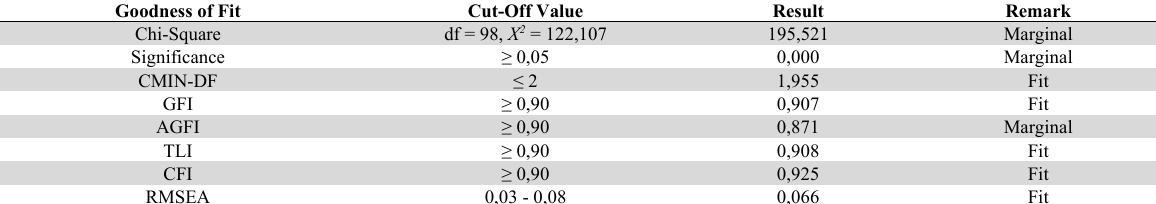
Confirmatory Factor Analysis